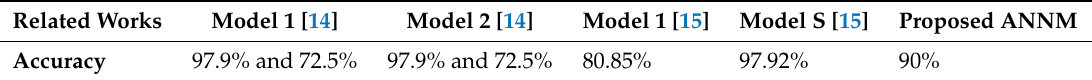
Table 14. Comparison of classification accuracy with related